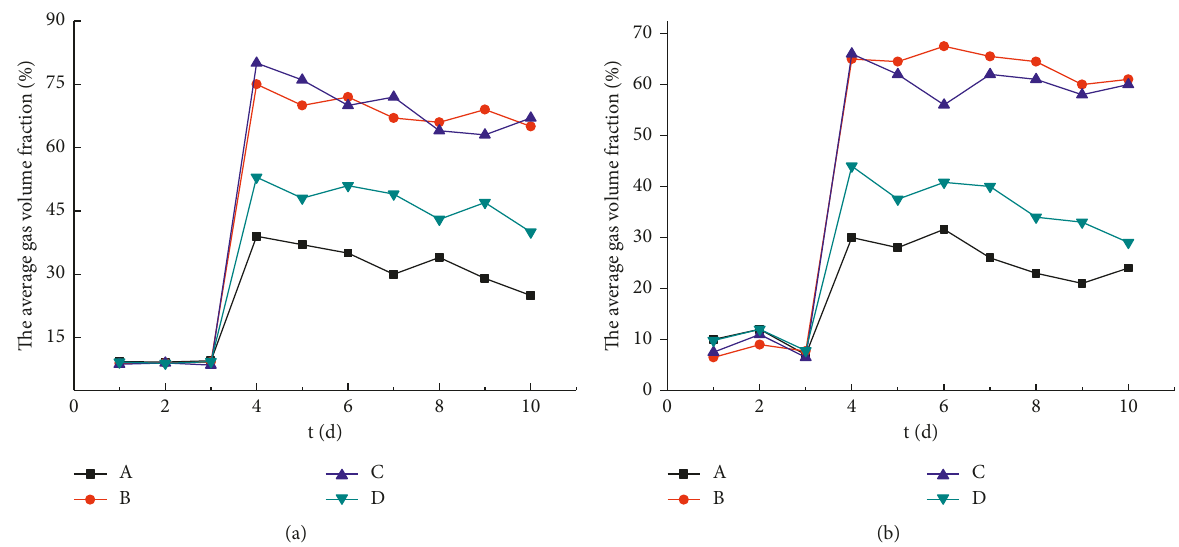
Figure 12: The average volume fraction of gas before and after cumulative blasting. (a) The first stage. (b) The second